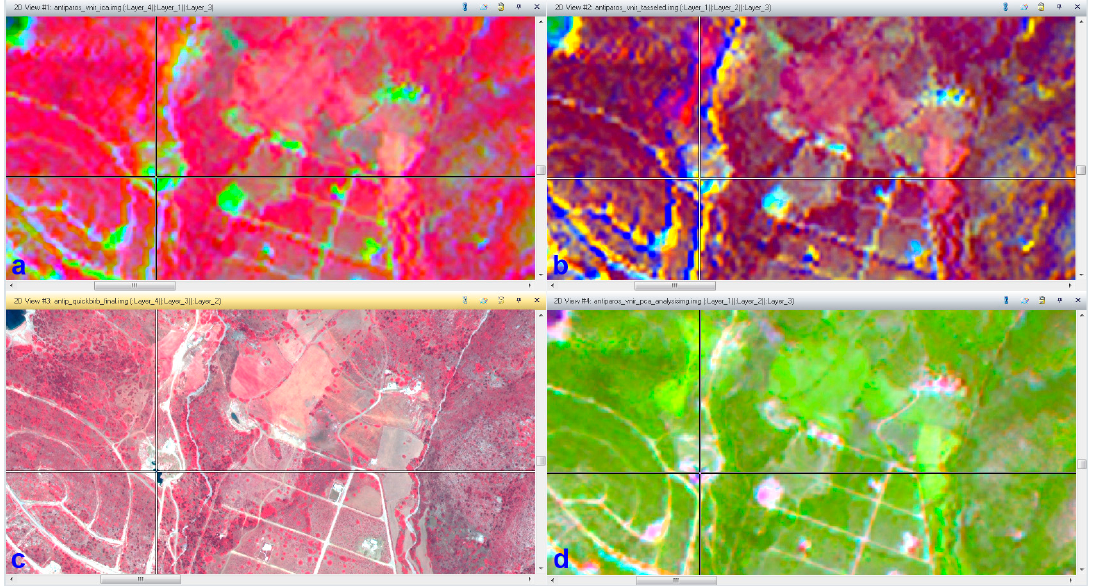
Figure 2. Example of the application of the PCA, ICA and Tasseled Cap techniques on remote sensing data is presented (area 4). The hydrothermal alterations are presented with green color in the ALOS VNIR ICA image ( a ) and with cyan color in the ALOS VNIR Tasseld Cap image ( b ). The same area is presented in a 432 RGB combination of the Quickbird image ( c ) and with red color in the ALOS VNIR PCA image ( d ).